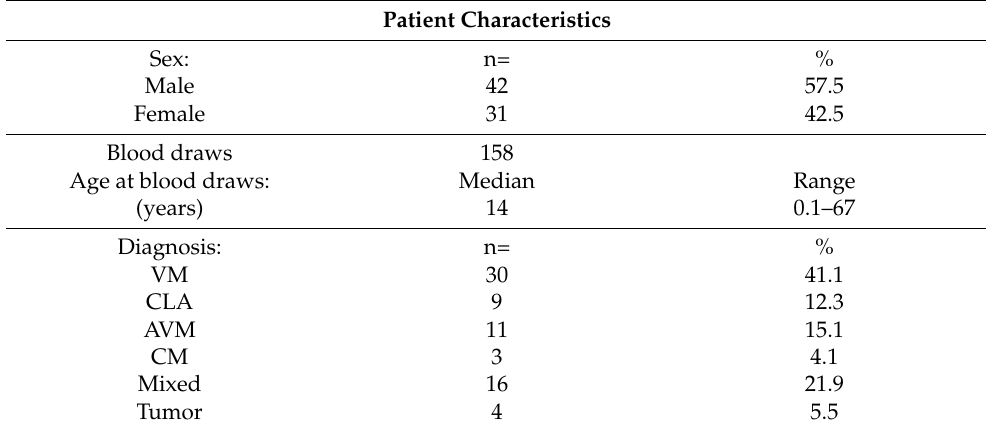
Table 1. Patient characteristics. Abbreviations: VM = venous malformation, CLA = complex lym- phatic anomaly; AVM = arteriovenous malformation, CM = capillary malformation. Patient Characteristics